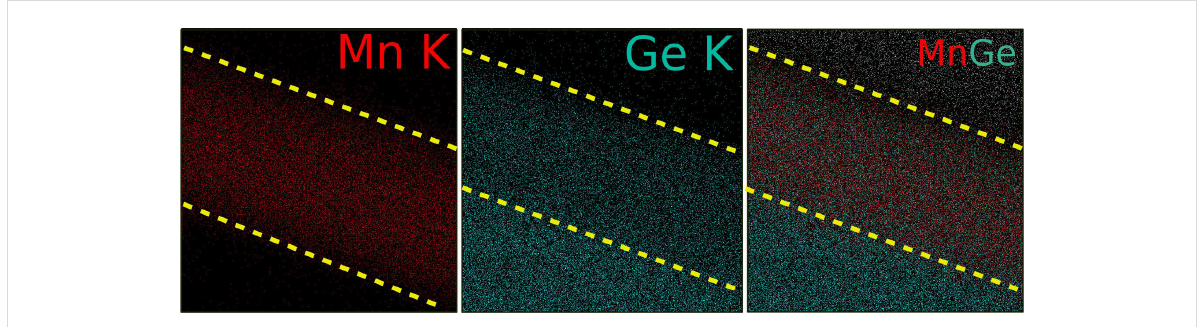
Figure 5: EDX elemental map (K α line), carried out on a cross-section of a NW on the surface of the 4.5 ML thick Mn film showing the distribution of Mn, Ge, and Ge + Mn in the NW and in the buffer layer. In all panels the dashed lines highlight the NW region.